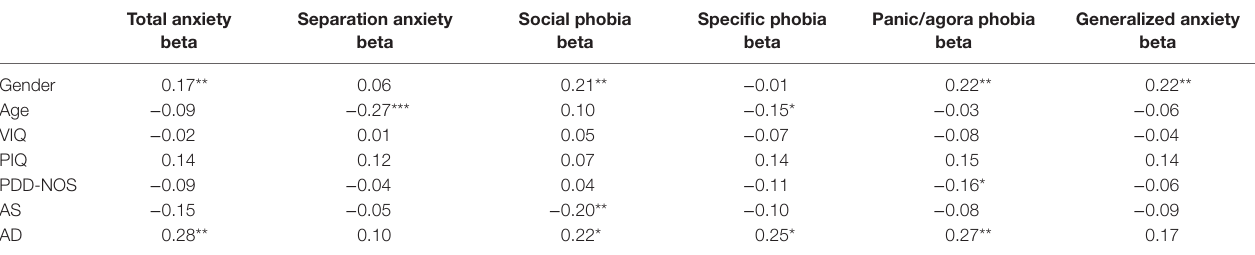
Table 4 | Path Analyses with Age, Gender, IQ (VIQ, PIQ), and ASD subtype (autistic disorder, Asperger disorder, and PDD-NOS) as Predictors and Parent-rated Symptoms of Total Anxiety, Separation Anxiety, Social Phobia, Panic Disorder/Agoraphobia, Specific Phobia, and Generalized Anxiety as Dependent Variables.